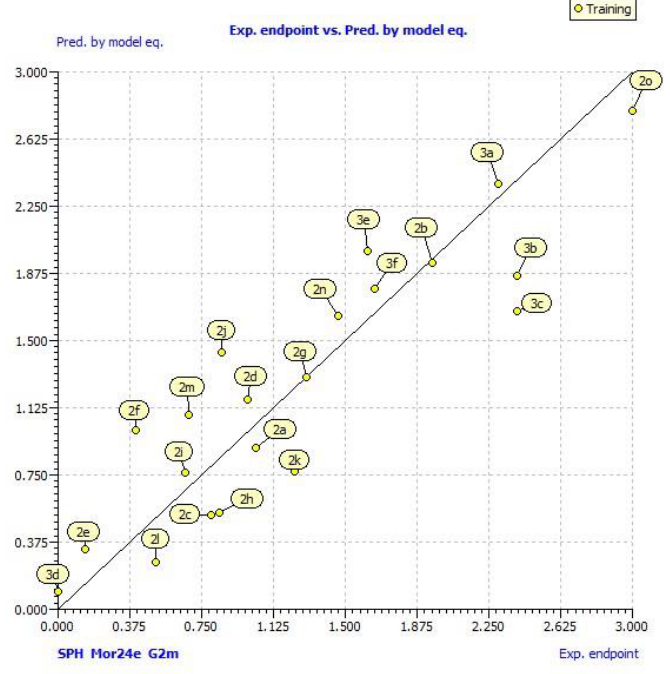
Figure 2. Observed versus predicted log DPPH for the 21 derivatives of rhodanine calculated by model (1).